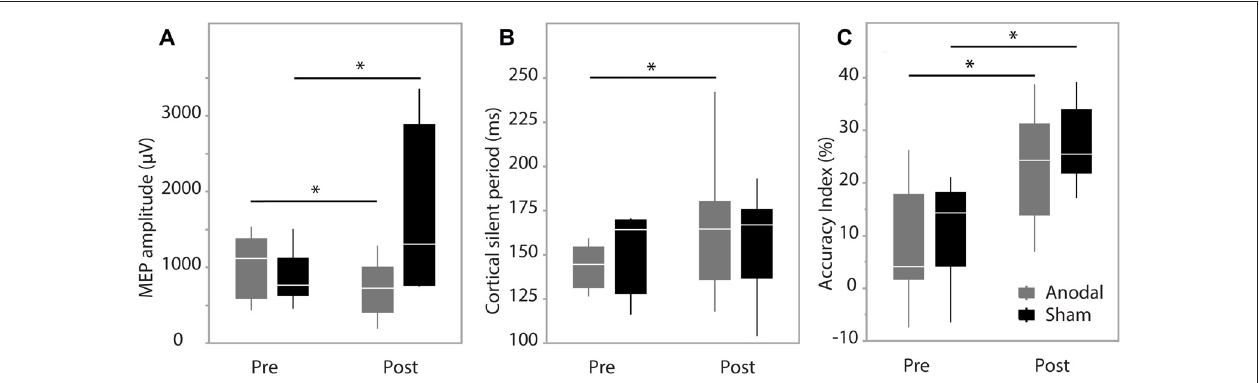
FIGURE 3 | Pre-test and post-test data. (A) Motor evoked potential (MEP) amplitude; (B) cortical silent period (CSP) duration; (C) accuracy index (AI). Data are median and range with 95% confidence intervals. ∗ Significant result, p < 0.05.